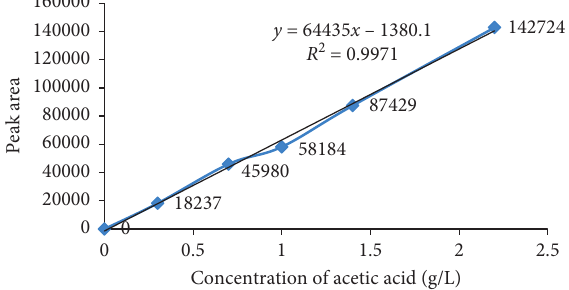
Figure 7: The linear plot between peak area in chromatogram and concentration of acetic